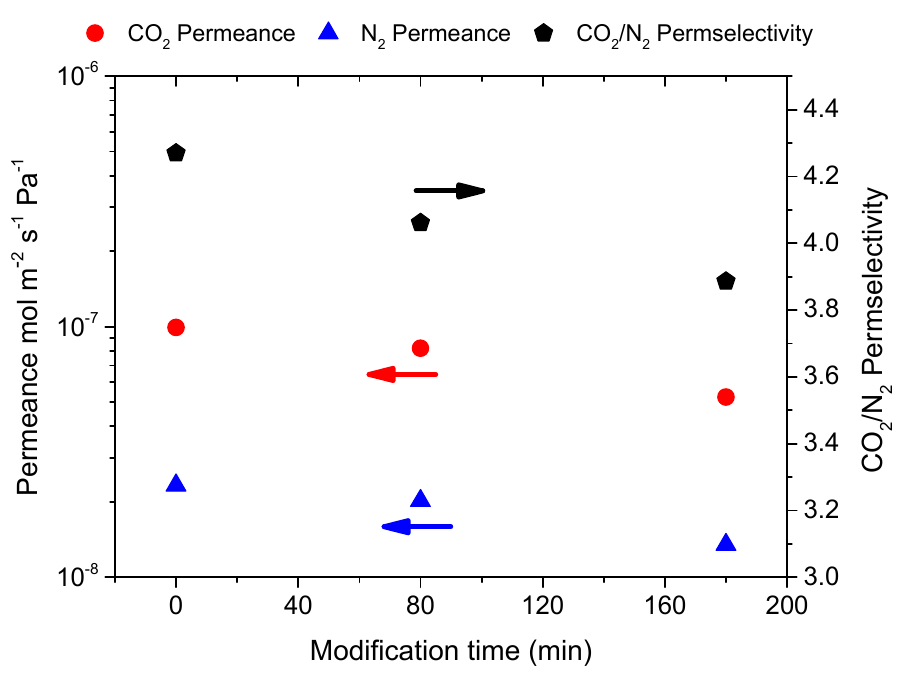
Figure 3. Single gas permeance of CO 2 and N 2 measured at 60 °C, P f = 3 bar and their ideal selectivities for membrane M-A as a function of the modification time.